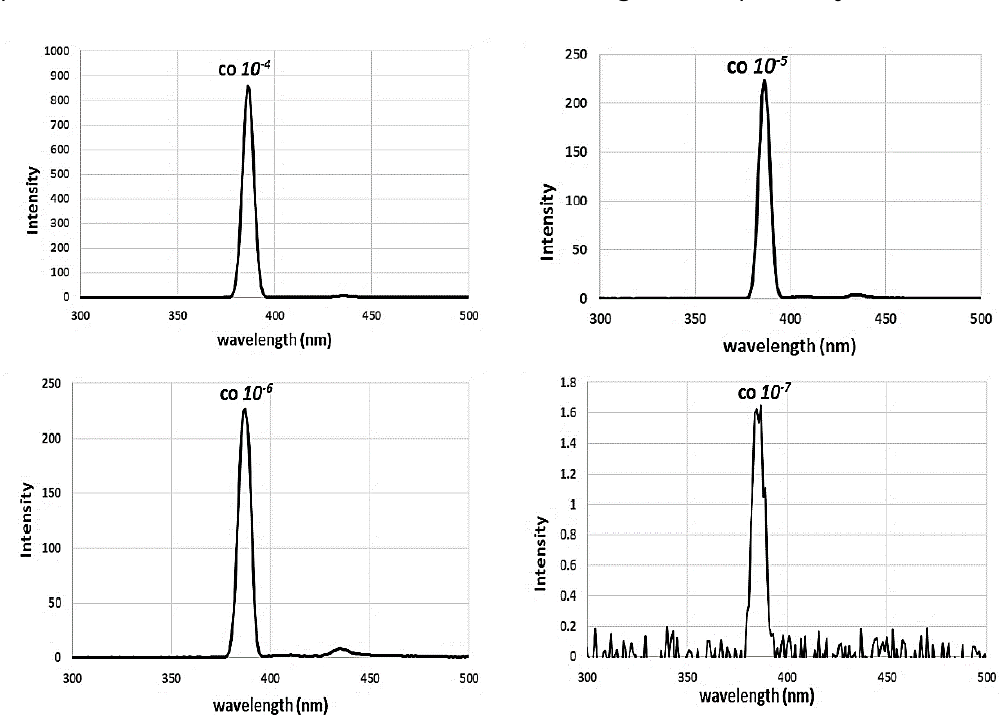
Fig.6: Fluorescence spectrum of Cobalt chloride with concentrations